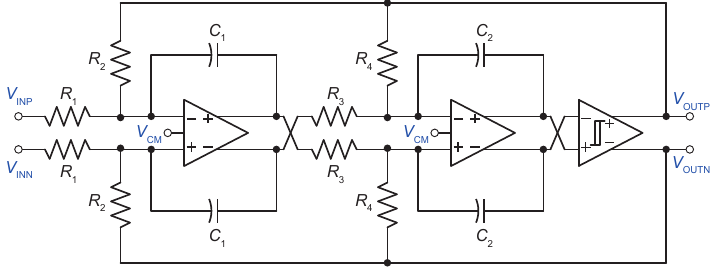
Figure 4. Proposed second-order asynchronous delta–sigma